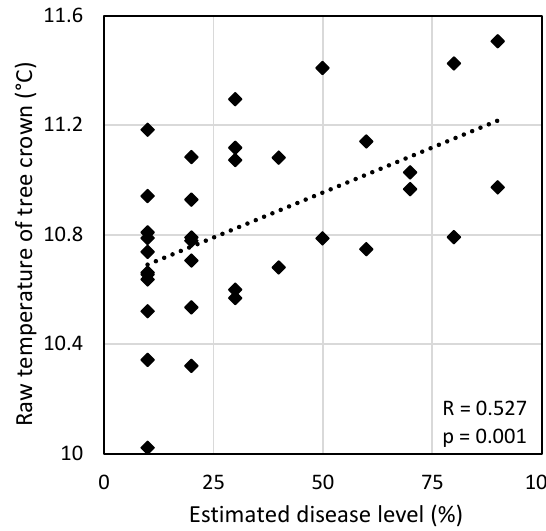
Figure 13. The observed relationship between the raw canopy temperature values and the estimated disease level in one